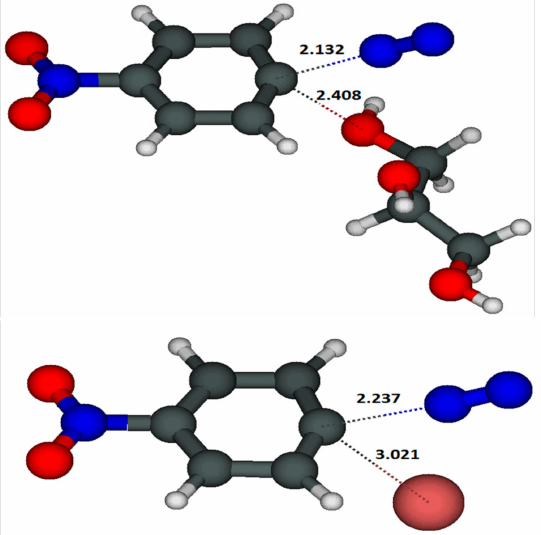
Figure 4. Transition structures for the solvolysis ( up ) and for the bromination ( down ) of 1a’ in glycerol. Unreactive explicit glycerol solvent molecules have been removed for clarity.